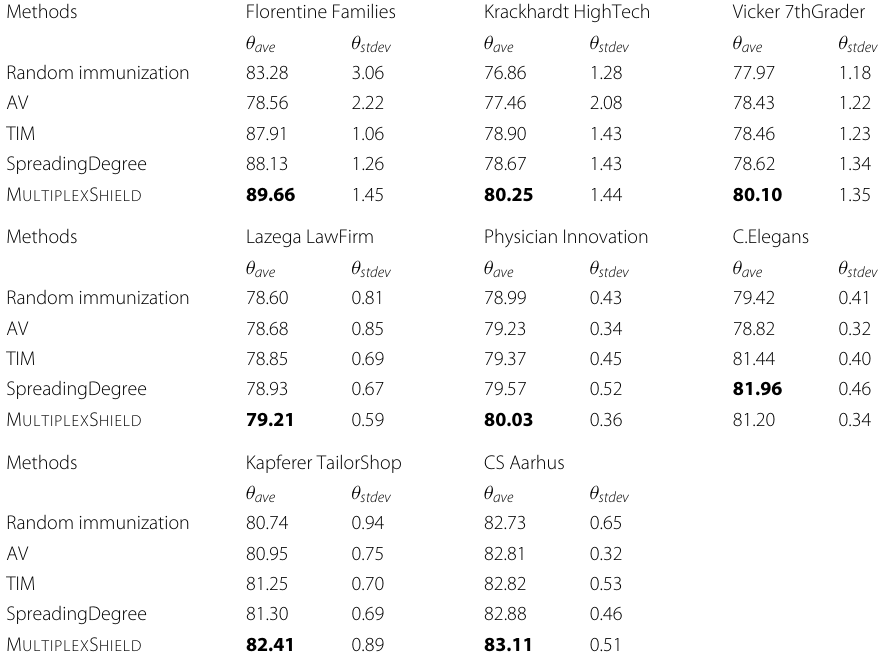
Table 5 Multiplex-based protection scheme, targeted high-degree nodes attack scenario